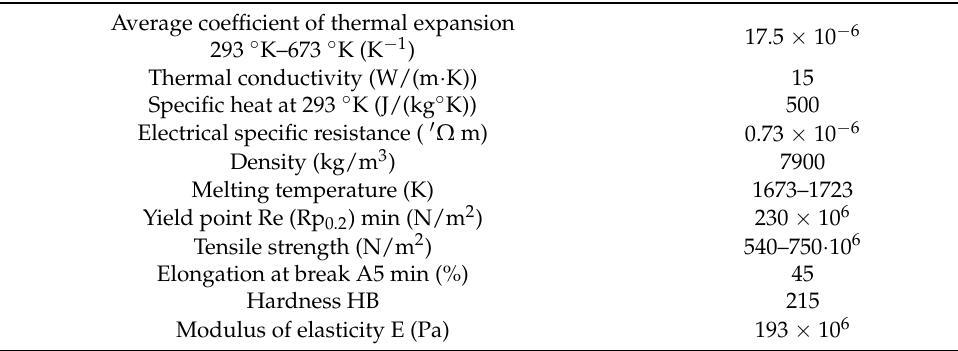
Table 1. Physical and mechanical properties of austenitic steel EN 1.4301.